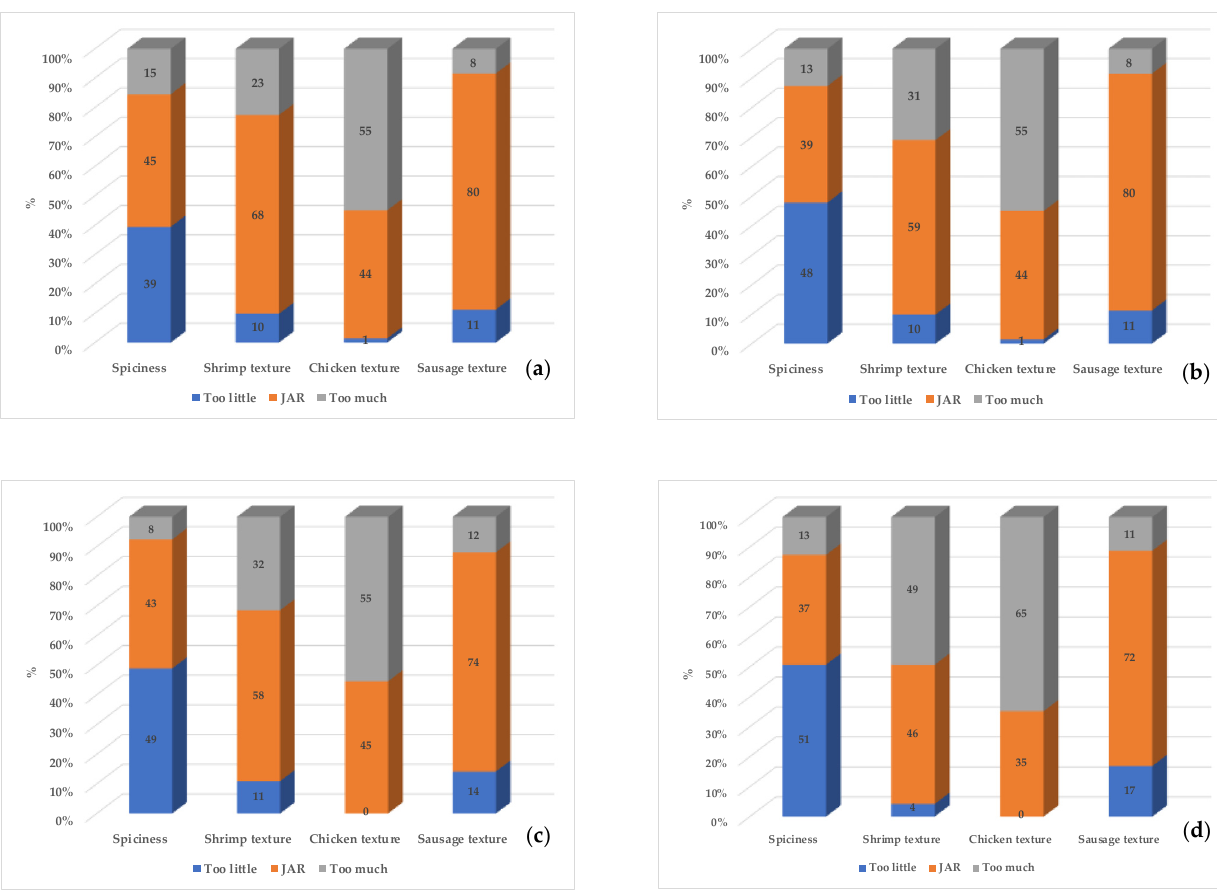
Figure 3. Percentage of responses for the indicated anchor of the JAR scale in the sensory evaluation of the intensity of spiciness and texture of the three meat components of the jambalaya meals (MAPS-processed and control) over a 12-week storage period ( n = 71). ( a ) Control after 2 weeks of storage; ( b ) Control after 12 weeks of storage; ( c ) MAPS-jambalaya after 2 weeks of storage; ( d ) MAPS-jambalaya after 12 weeks of storage.